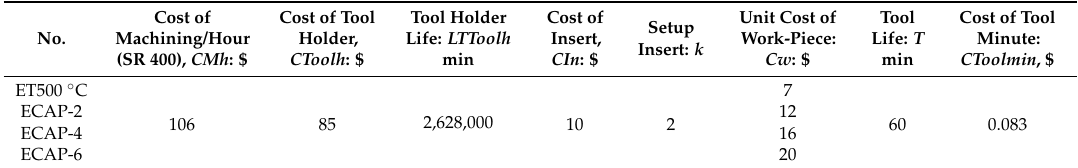
In Table 3 the parameters LTToolh and CToolmin are calculated according to the